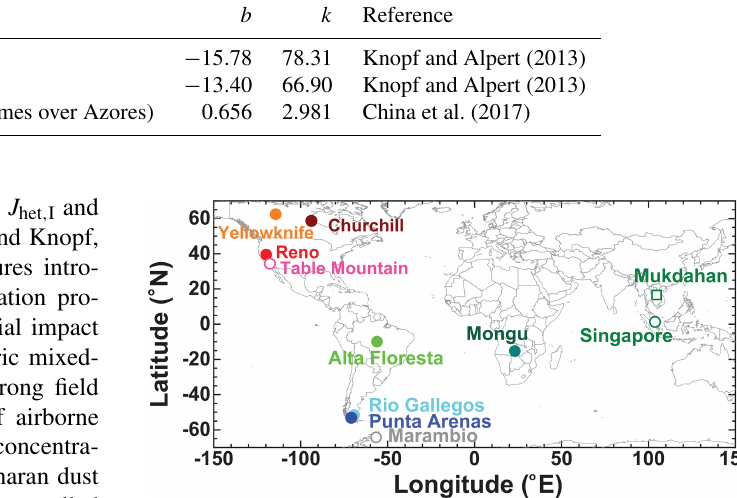
Figure 2. AERONET stations used in our study. Aged stratospheric smoke from the major Australian bush fires was observed over the South American and Antarctic stations (Rio Gallegos, Punta Are- nas, Marambio) in January and February 2020. Fresh and aged stratospheric smoke from record-breaking fires in British Columbia, Canada, were measured over Yellowknife and Churchill, respec- tively, in August 2017. Mixtures of fresh and aged tropospheric smoke originating from strong fires in the western United States and Canada were found over Reno and Table Mountain in late August to mid-October 2020. AERONET stations at Alta Floresta, Mongu, Mukdahan, and Singapore have long, multiyear data records of smoke observations in key regions of biomass